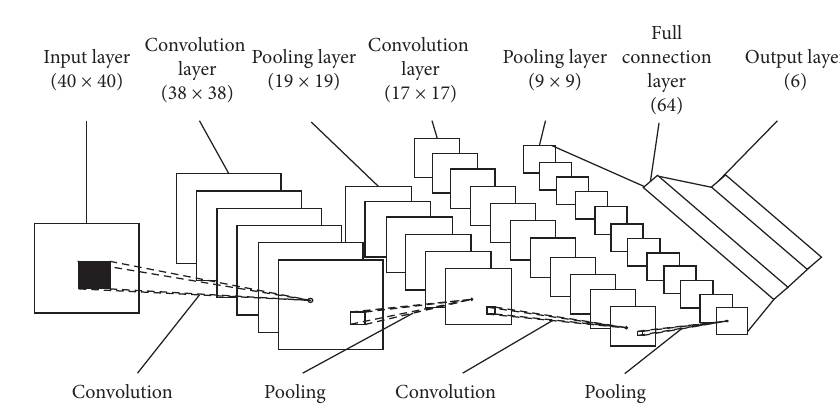
Figure 7: Normalization